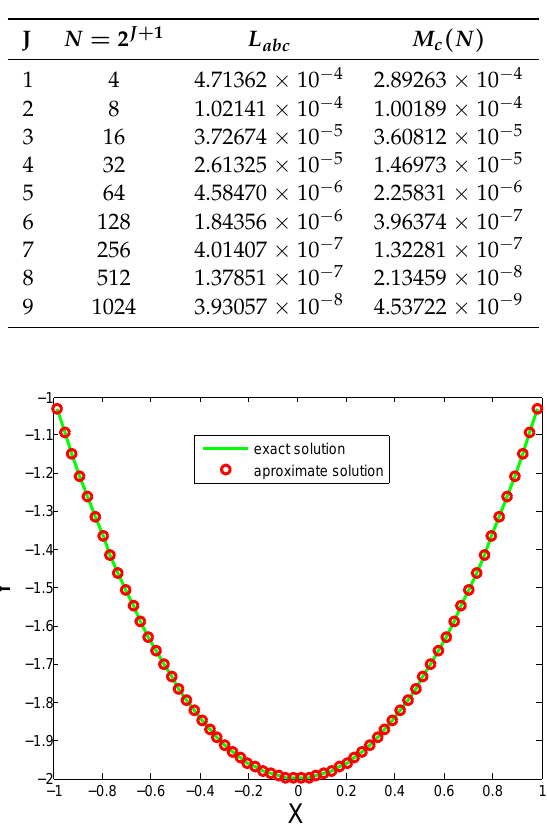
Table 3. L abc and M c ( N ) errors for Test Problem 3.